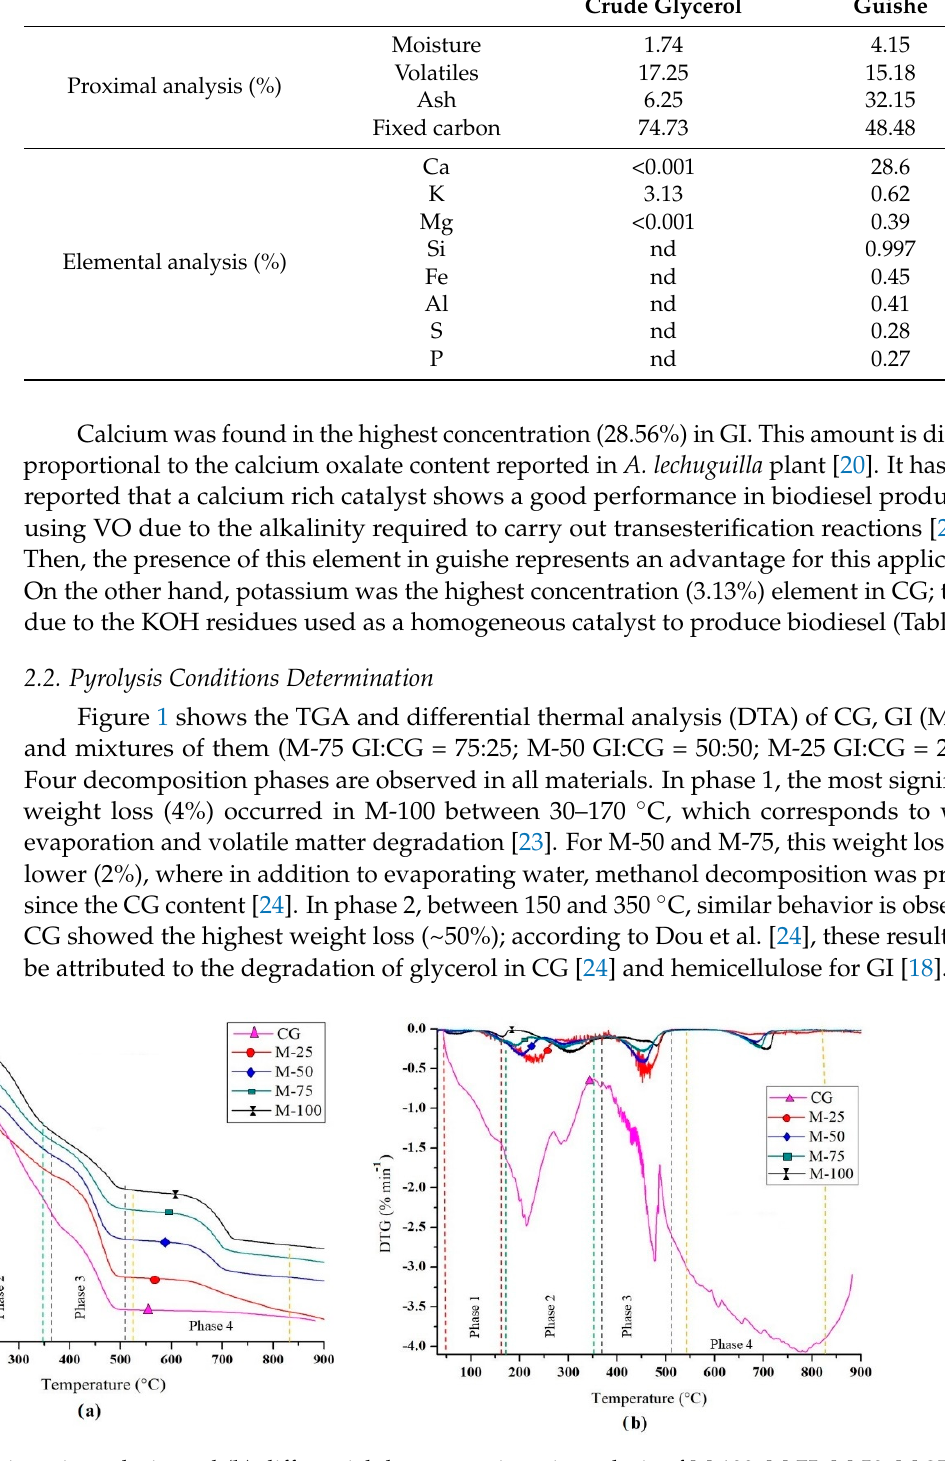
Figure 1. ( a ) Thermogravimetric analysis, and ( b ) differential thermogravimetric analysis of M-100, M-75, M-50, M-25, and CG.